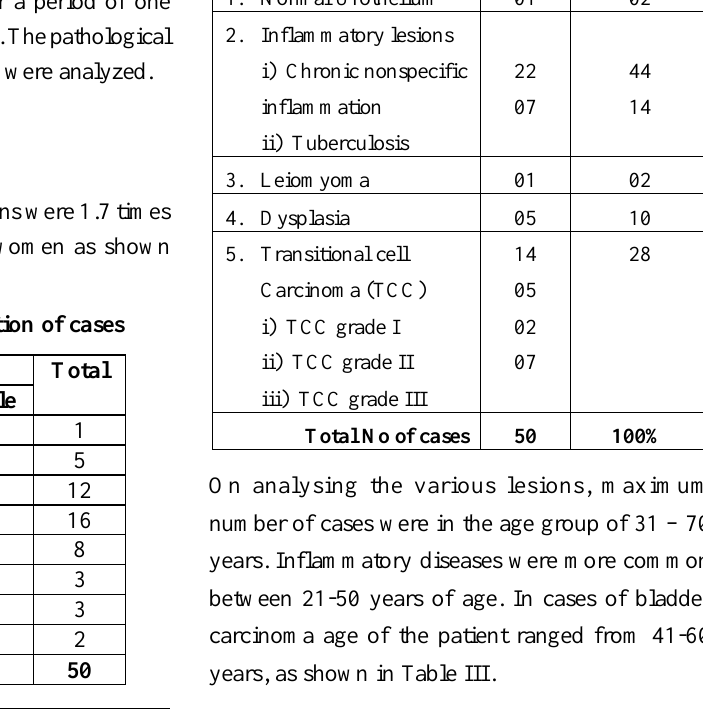
Table III : Age wise distribution of